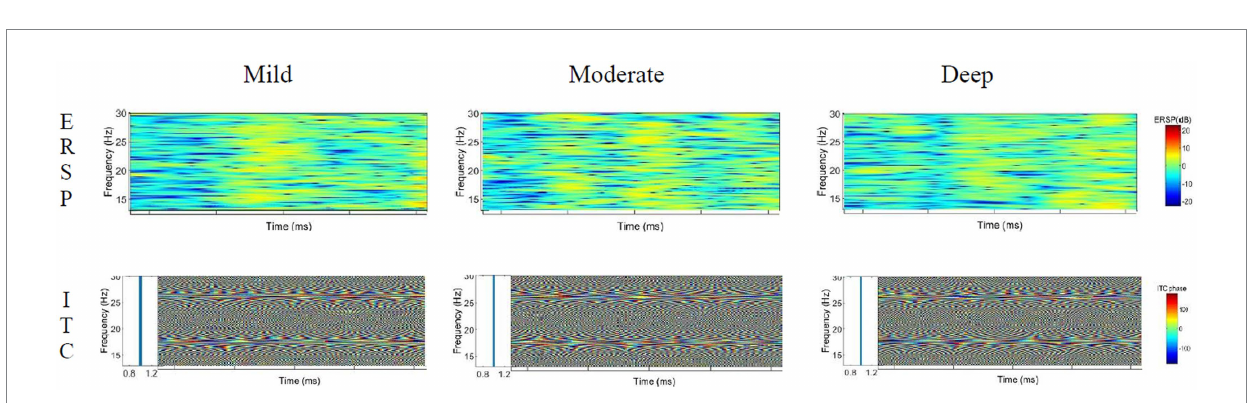
FIGURE 12 ERSP and ITC characteristics of the beta wave under different cognitive workload events.